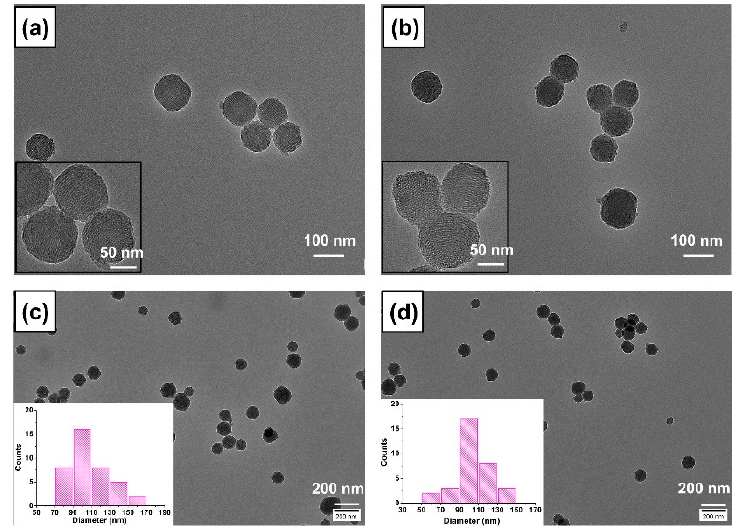
Figure 2. TEM images of ( a ) SiO 2 NPs (amplified image), ( b ) SiO 2 -NH 2 NPs (amplified image), ( c ) SiO 2 NPs (the particle size distribution as an inset), ( d ) SiO 2 -NH 2 NPs (the particle size distribution as an inset). The histograms were generated by measuring the diameter of about 40 particles from the TEM images.